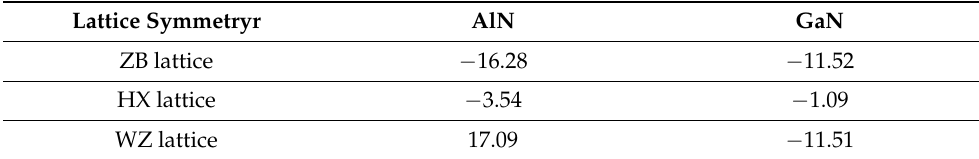
Table 2. Crystal orbital Hamilton population (COHP) overlaps Δ𝑊 (in eV) Lattice symmetryr